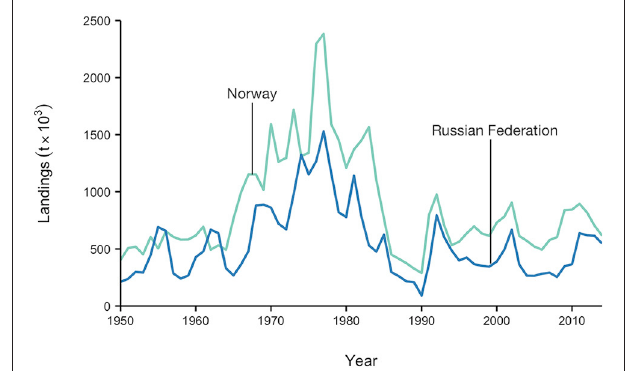
FIGURE 4 | Total reconstructed Russian catch in the Barents Sea, including discards and landings. Reported data (landings only) are overlaid as a black line graph. Fishing effort by the Russian fleet in the Barents Sea from Greer (2014) are overlaid as a secondary black dashed line graph. Note the separate